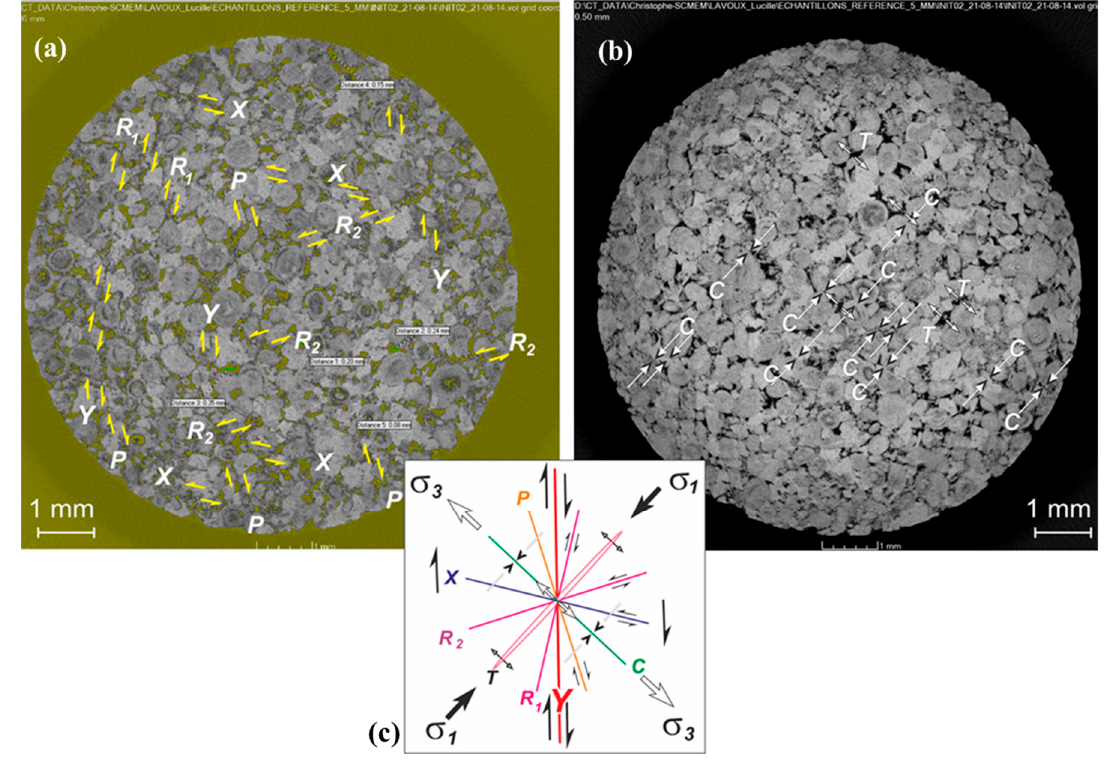
Figure 3. ( a ) CT scans of a sample of the Lavoux limestone (resolution 5 µm) in sub-horizontal sections with delineation within them at microscale-level planar fractures of Y, R 1 , R 2 , P, and X types with identification of the direction of shear displacement (double yellow arrows); ( b ) stylolitic contacts of ooids C (white arrows), and dilatational joints; ( c ) Note, CT scans and the constructed (on the basis of interpretation of obtained kinematic types of fractures) model of formation of subsidiary fractures (modified from Hancock [27]) within dextral strike-slip zone are not azimuthally referenced.